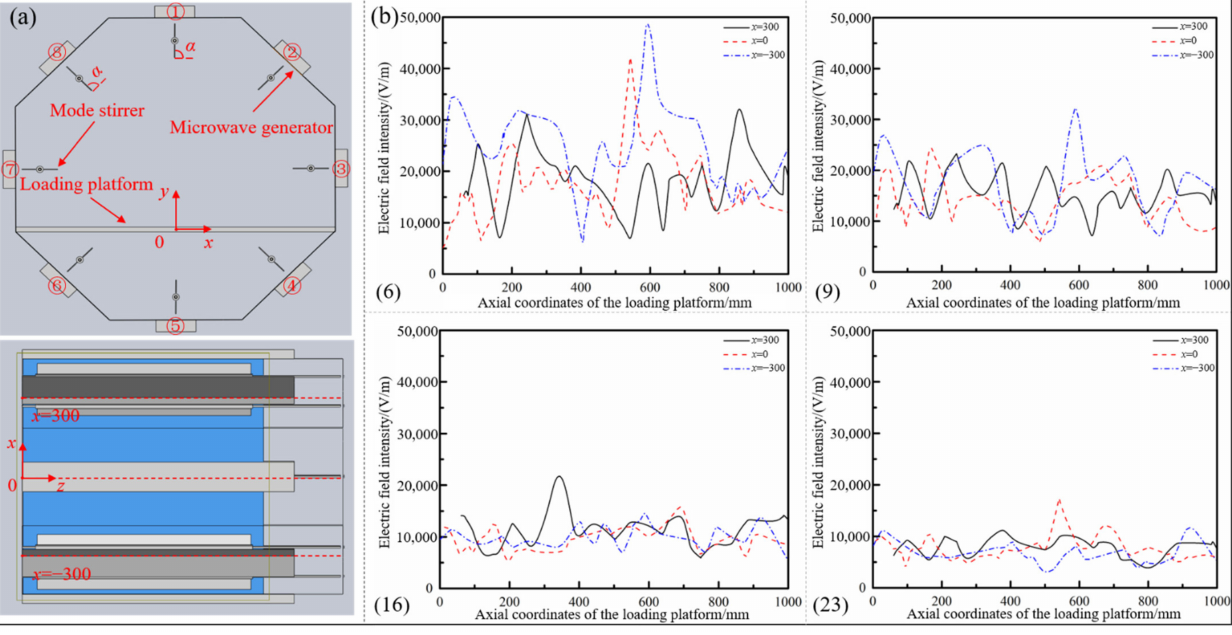
Figure 7. ( a ) Establishment of the associated coordinate system; ( b ) electric field intensity curves under different microwave generators working